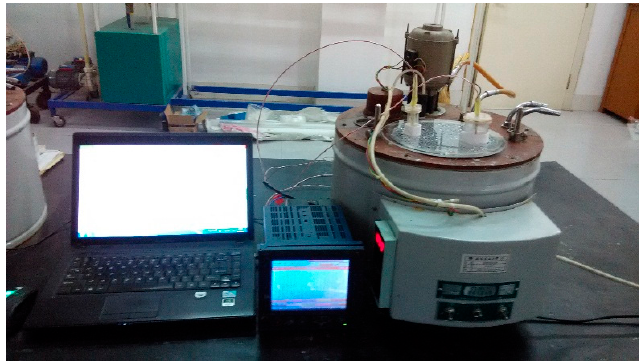
Figure 4. The constant temperature water bath test system for PCM cylinder modules. Table 2. Arrangements of constant temperature water bath